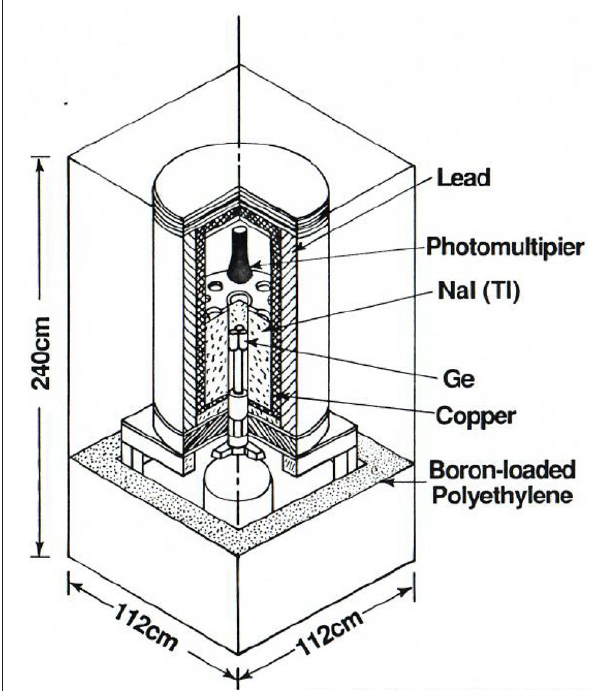
FIGURE 2 | A diagram of the Caltech, Nuchâtel, PSI experiment with four natural abundance, high-purity Ge detectors.